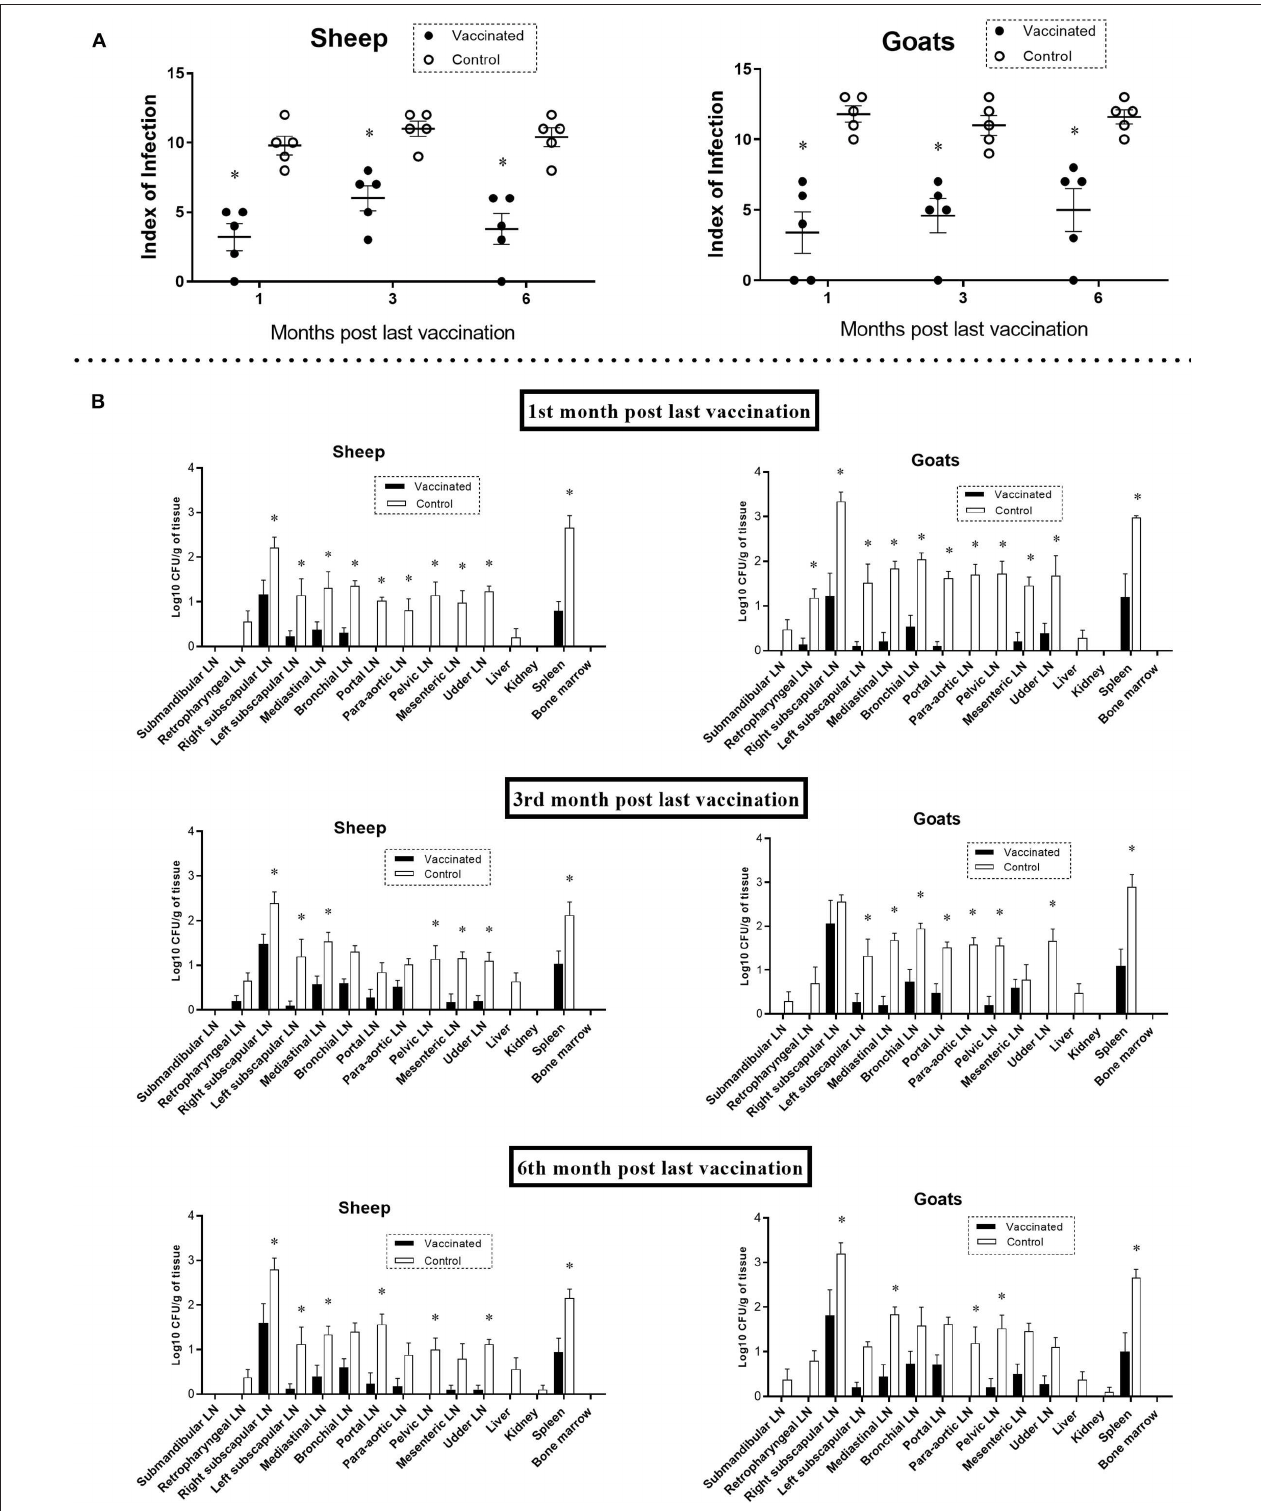
FIGURE 3 | Index of Brucella infection (A) and Brucella melitensis colonization in tissues (B) of sheep and goats challenged with B. melitensis 16M at first, third, and sixth month post–last vaccination. Sheep and goats in the vaccinated group were immunized thrice concurrently via the subcutaneous and conjunctival